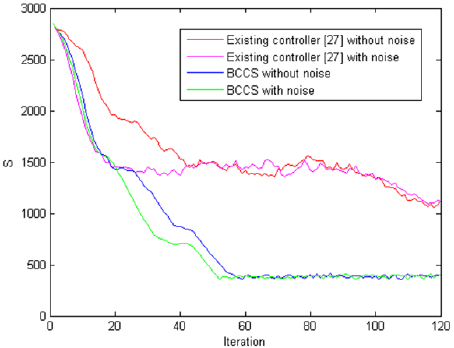
Figure 17. The S evolution of two methods without and with noise for aggregation. The red and